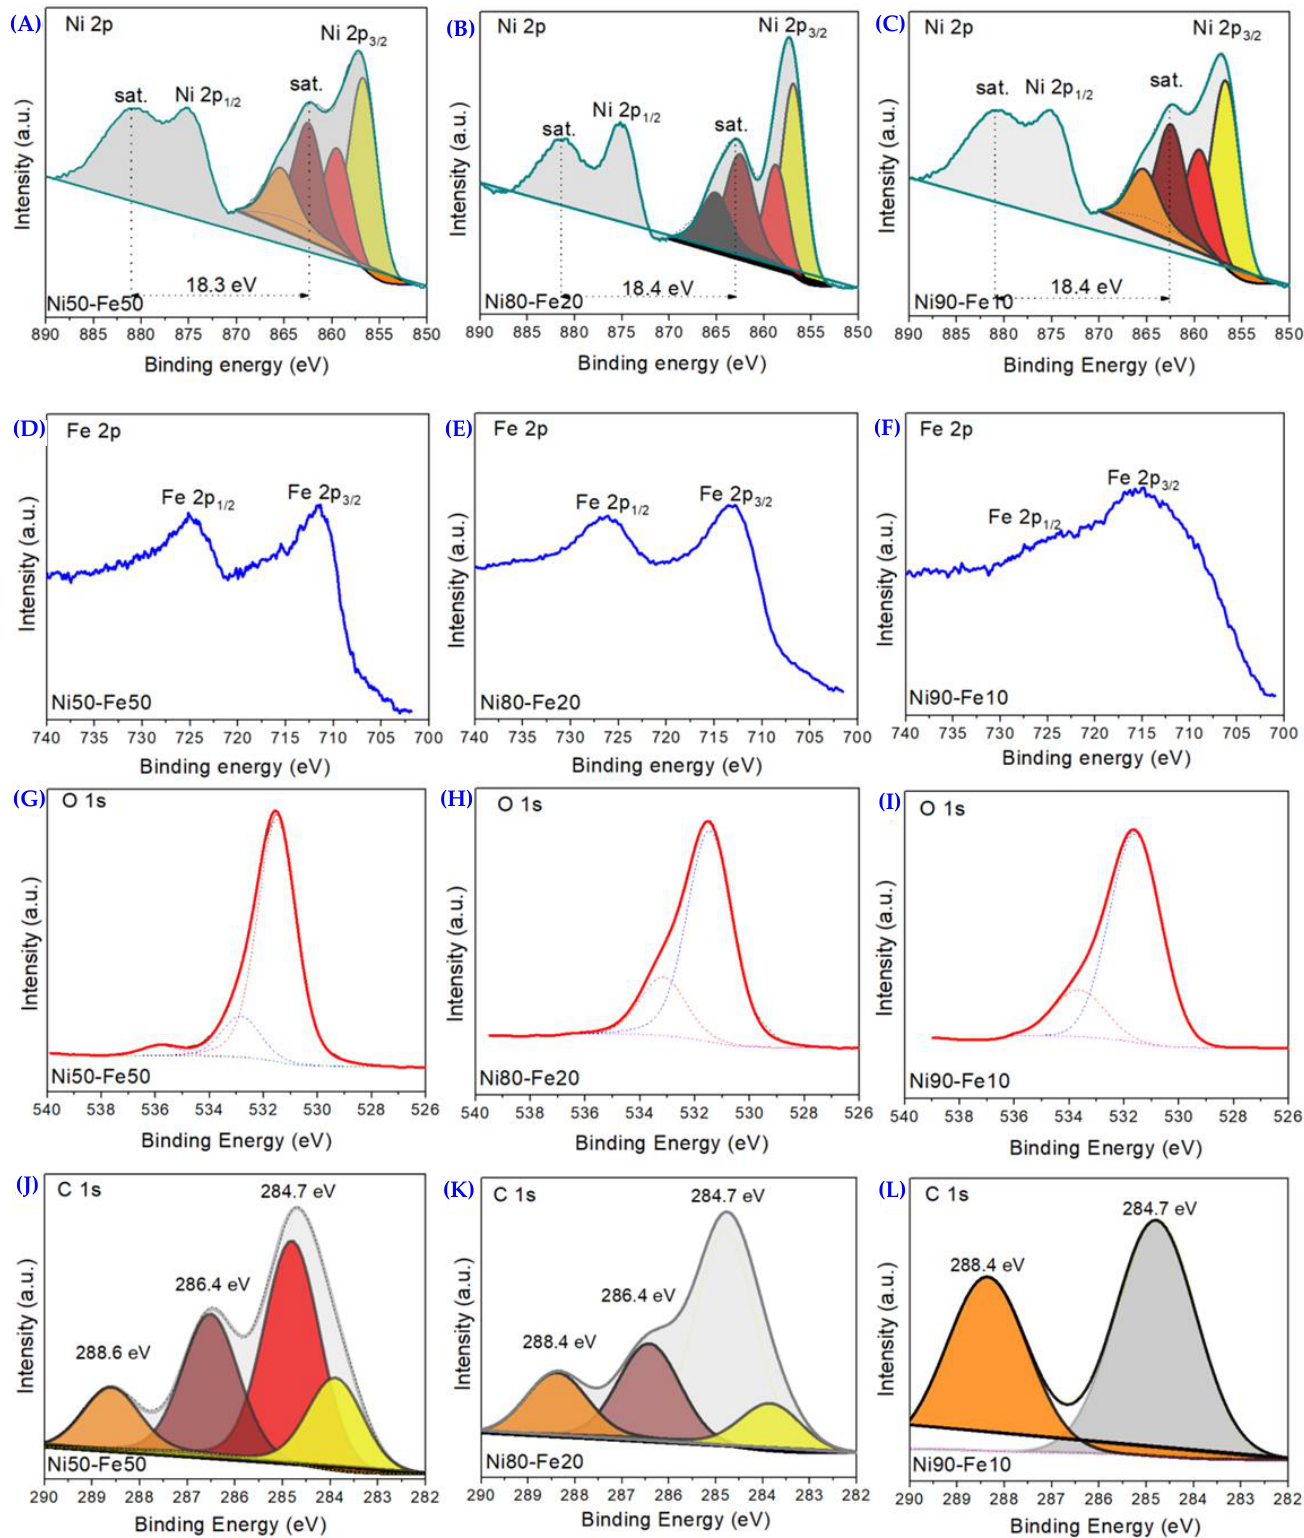
Figure 5. XPS spectra for ( A – C ) Ni 2p, ( D – F ) Fe 2p, ( G – I ) O 1s, and ( J – L ) C 1s of the samples as indicated.